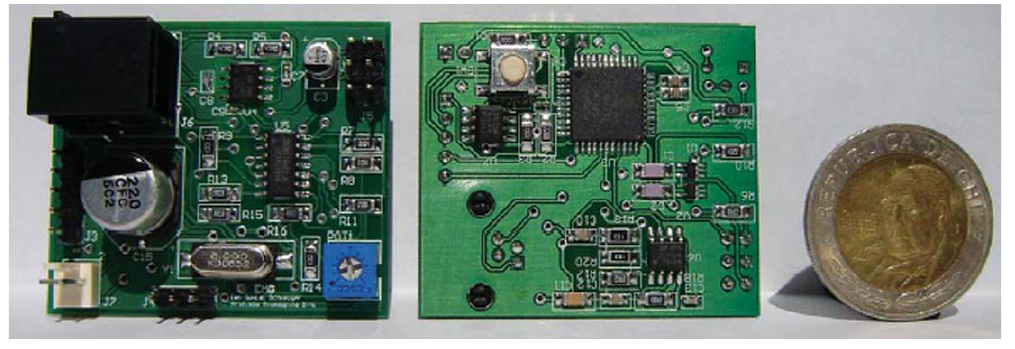
Fig. 7. The circuit compared with 1 euro coin.